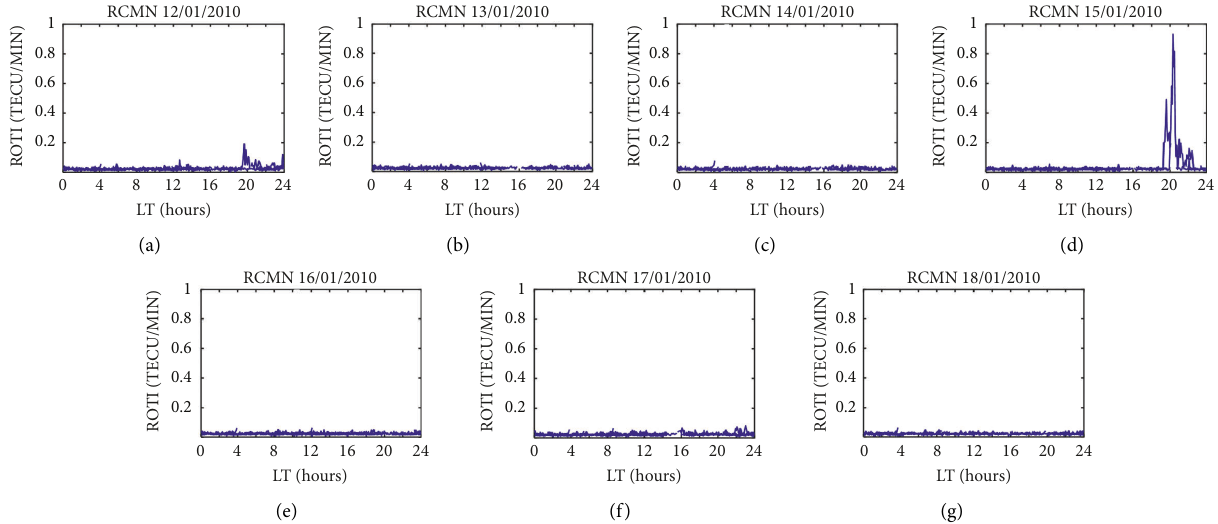
Figure 12: ROTI against LTover RCMN station for (a) 12 th January 2010, (b) 13 th January 2010, (c) 14 th January 2010, (d) 15 th January 2010, (e) 16 th January 2010, (f) 17 th January 2010, and (g) 18 th January